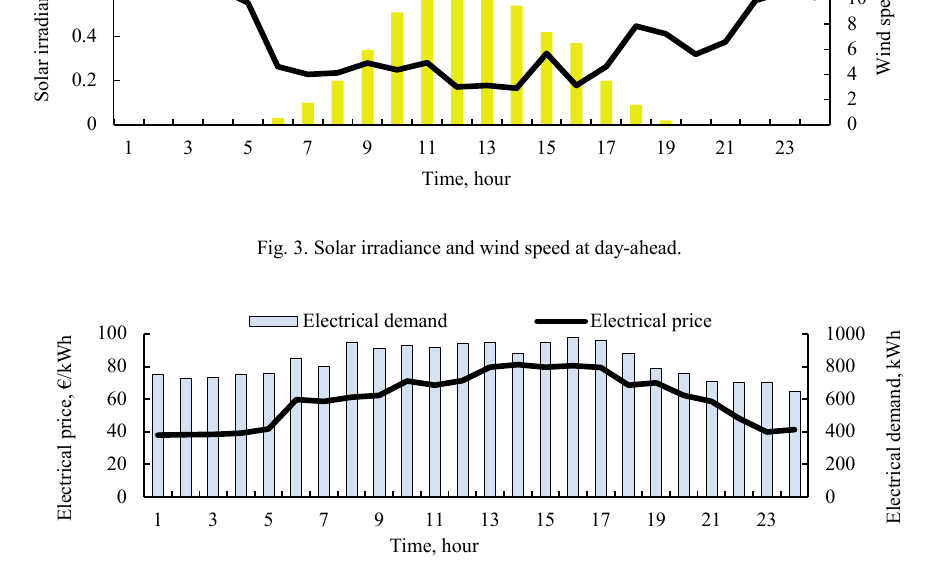
Fig. 4. Electrical demand and electrical price at